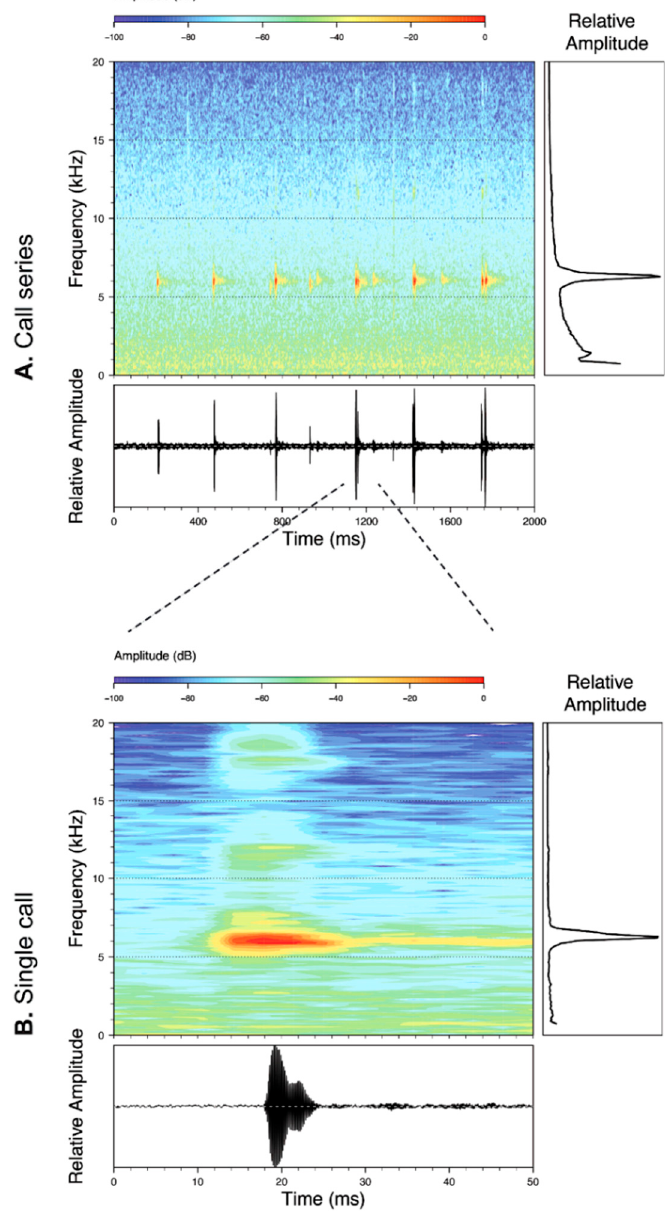
Figure 60. Call of Centrolene sanchezi (LBE-C-023), recorded at Reserva Yanayacu, 2150 m, Napo province, Ecuador. ( A ) Series of calls. ( B ) Single, pulsed call.